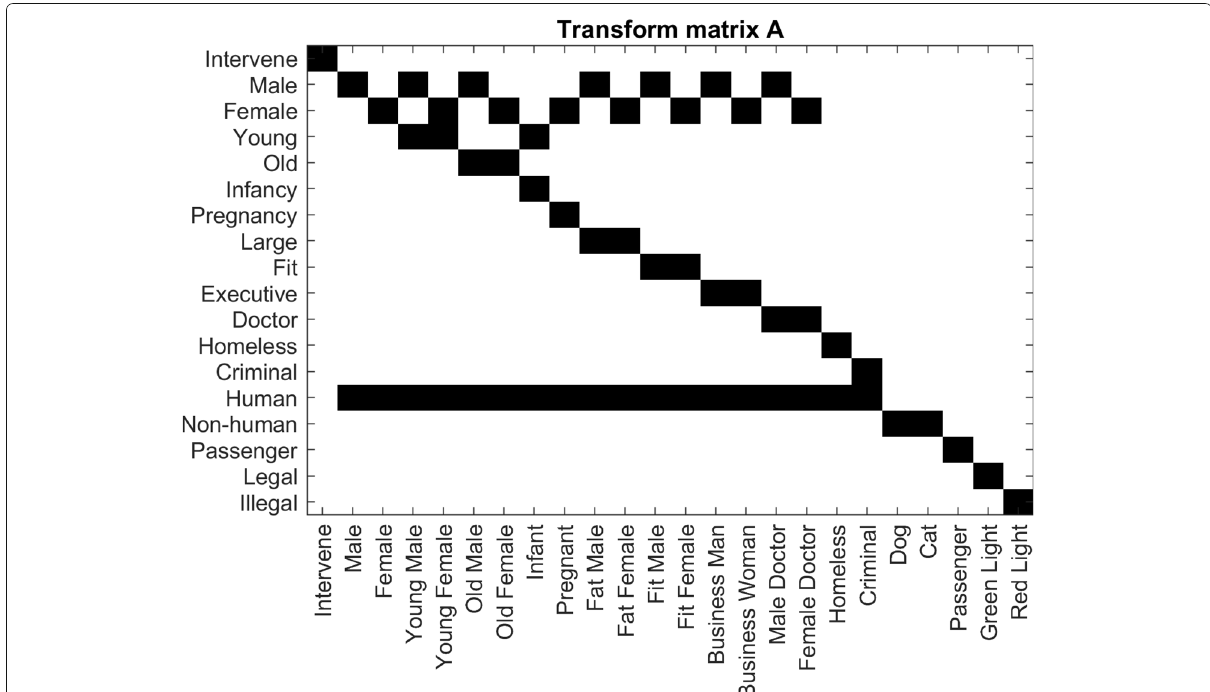
Fig. 2 Feature Transform: Binary transformation matrix A used in Kim, et al., which converts a set of character traits θ into quantifiable features [9]